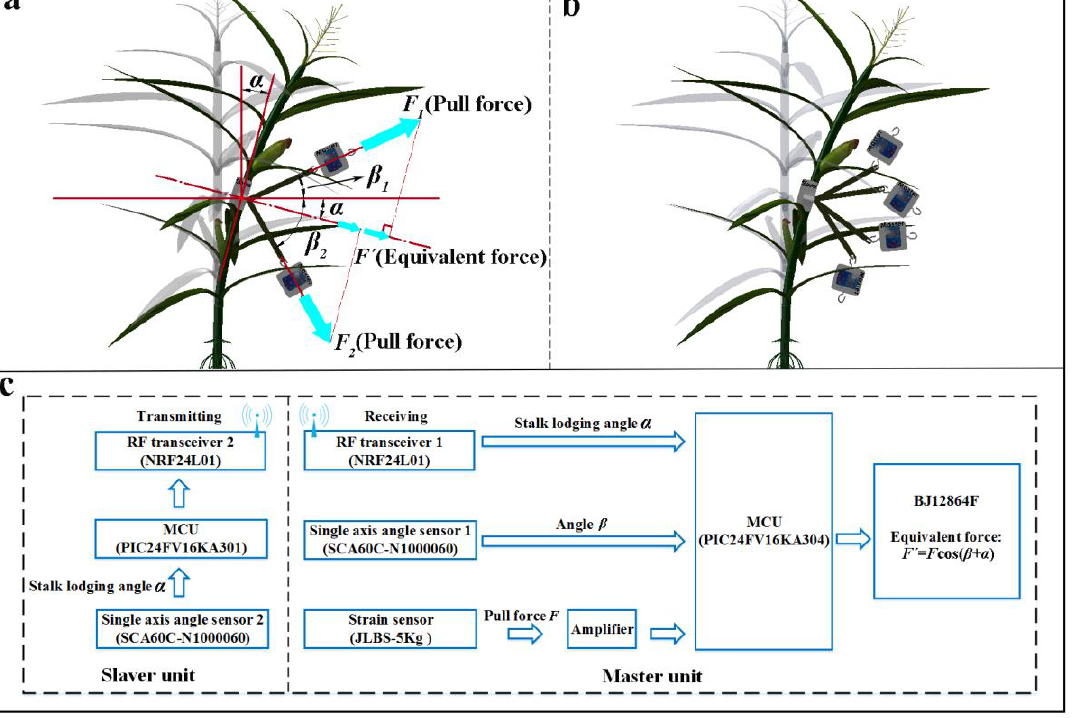
Figure 3. ( a ) Schematic diagram for the evaluation of stalk lodging properties under the pull force exerted upon the stalk; ( b ) some cases cannot occur during the experiment process; ( c ) the working schematics of the measurement system.